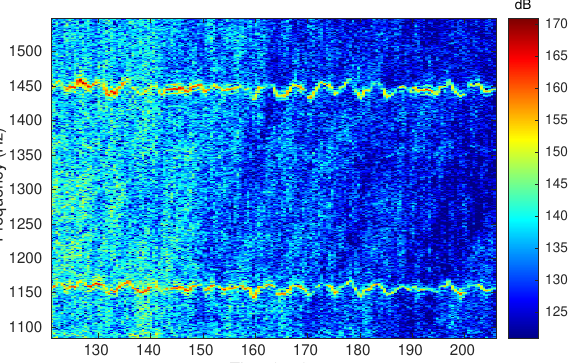
Figure 7. The spectrogram of the ship-radiated underwater sound at 82% propeller pitch ratio, showing two frequency-modulated (FM) narrowband tonal signals wavering within the frequency ranges of 1435–1460 Hz and 1145–1170 Hz.